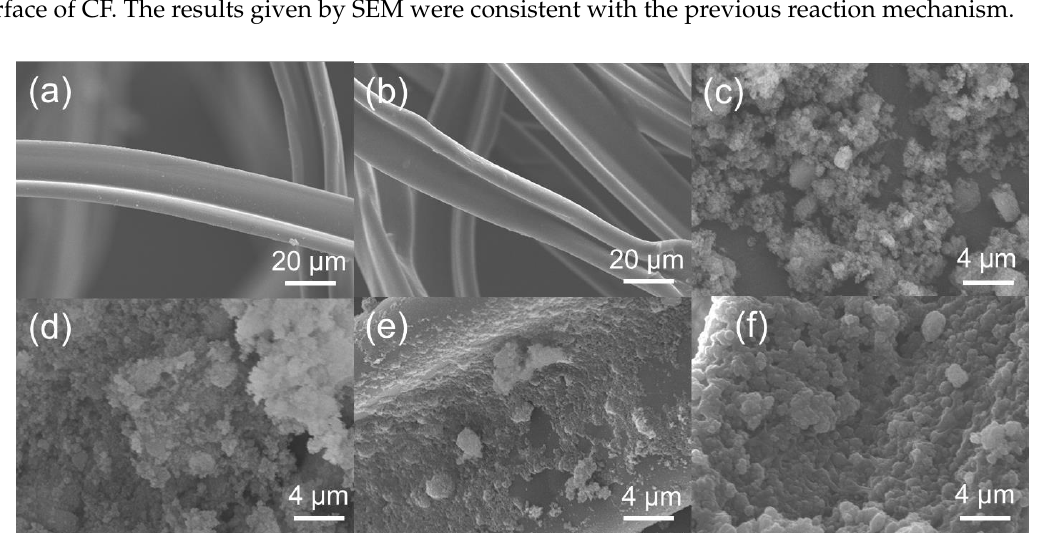
Figure 2. SEM images of new cigarette filter ( a ), used cigarette filter ( b ), SiO 2 particles ( c ), SiO 2 @OTS ( d ), CF modified by SiO 2 @OTS ( e ), and CF modified by SiO 2 @OTS@MTMS ( f ).